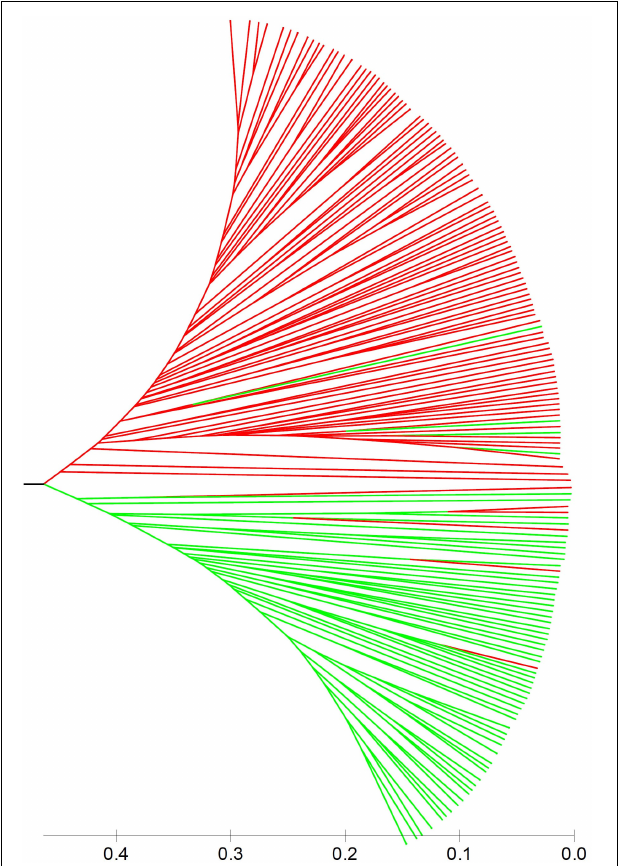
FIGURE 3 | A neighbor-joining tree of 212 melon accessions showing two main clusters. Red and green lines represented melo accessions and agrestis accessions,